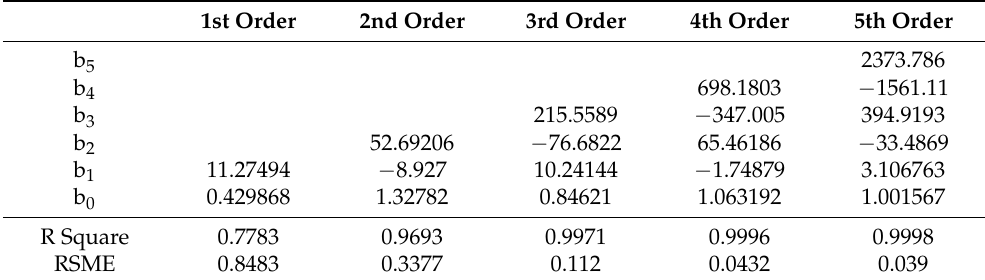
Table A1. Polynomial Fits of Viscosity